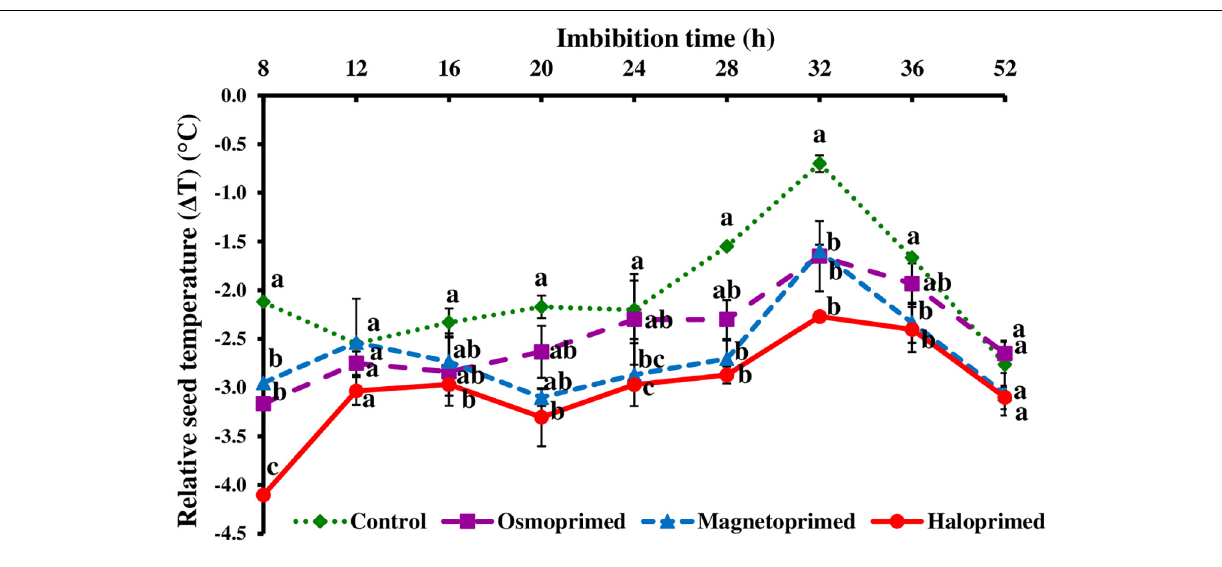
FIGURE 2 | Relative seed temperature ( (cid:49) T) of differently primed onion seeds at different imbibition time. Data represent mean ± SE of three biological replications. Different letters indicate significant differences among means based on LSD test ( p < 0.05). (cid:49) T was calculated as the difference between seed temperature and the zone affected by the thermogenic activity of the seed, providing the individual “seed calibration reference